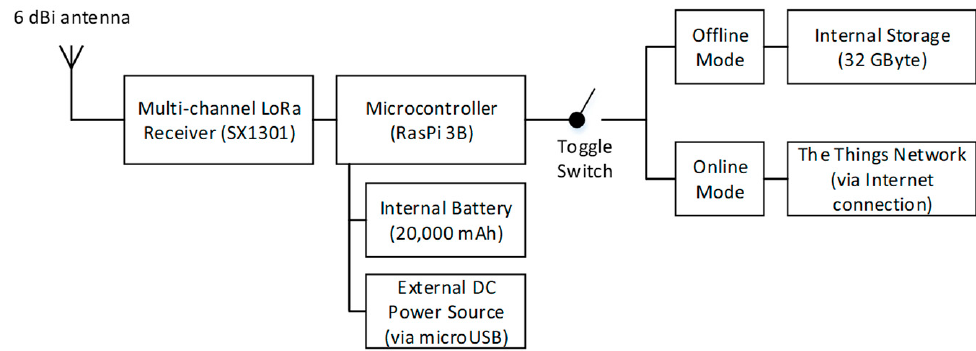
Figure 5. Block diagram of the modified LoRaWAN ® multi-channel GW.